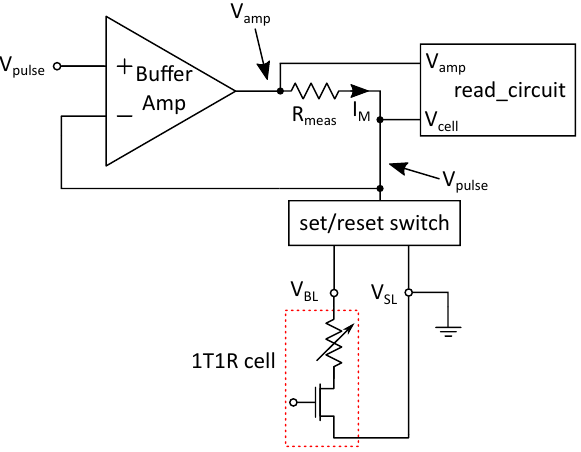
Figure 6. System configuration during read